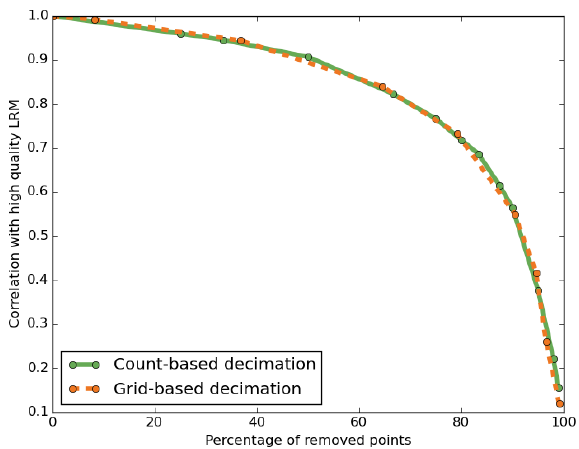
Figure 8: Comparison of the performance of count-based and grid-based decimation applied to a point cloud obtained using airborne lidar